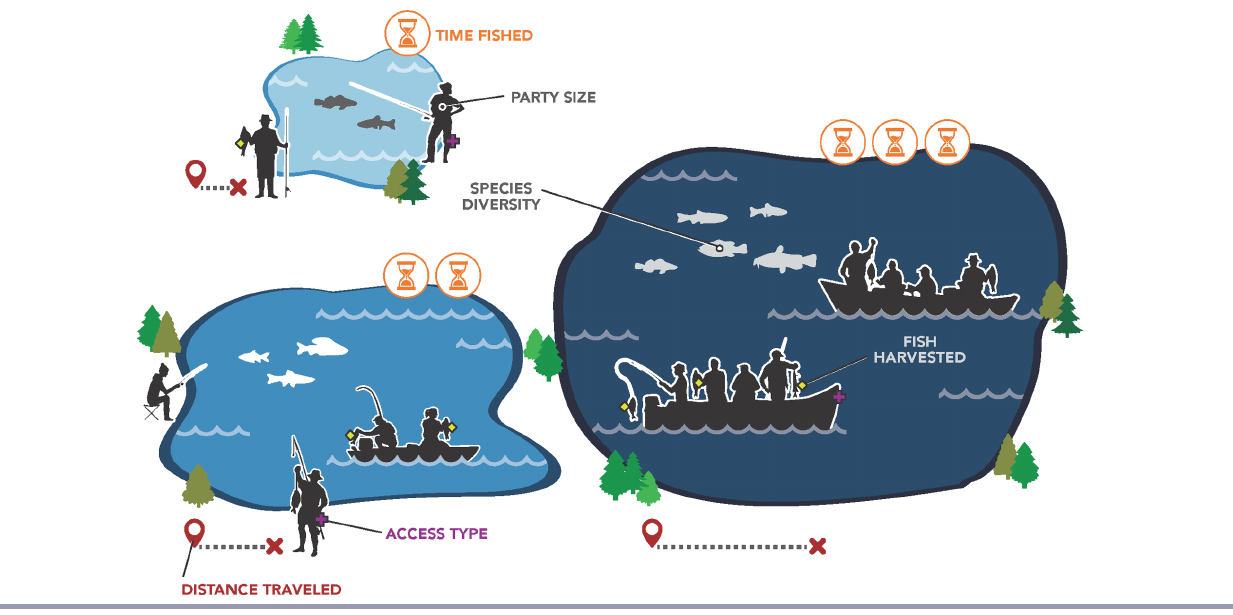
Fig. 6 . Conceptual infographic illustrating nonlinear angler behavior responses to water body size. Smaller water bodies are characterized by smaller fishing parties that travel shorter distances and are primarily accessed by bank; anglers at these smaller water bodies also fish for shorter periods of time, harvest fewer fish, and catch fewer species of fish. In contrast, larger water bodies are characterized by larger fishing parties that travel greater distances and are primarily accessed by boat; anglers at these larger water bodies also fish for longer periods of time, harvest more fish, and catch more species of